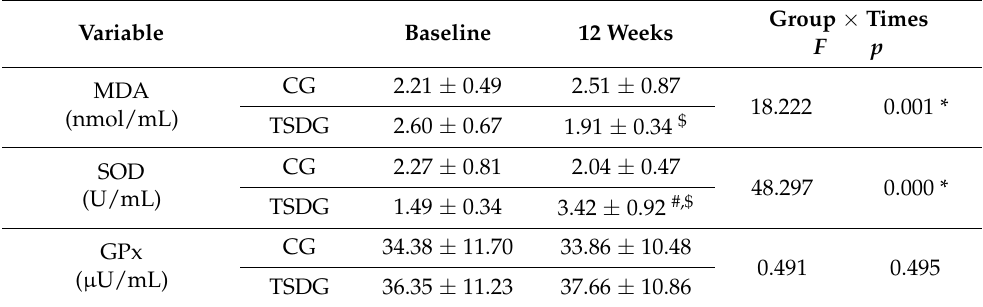
Table 6. Changes in oxidative stress after the 12-week Taekwondo training